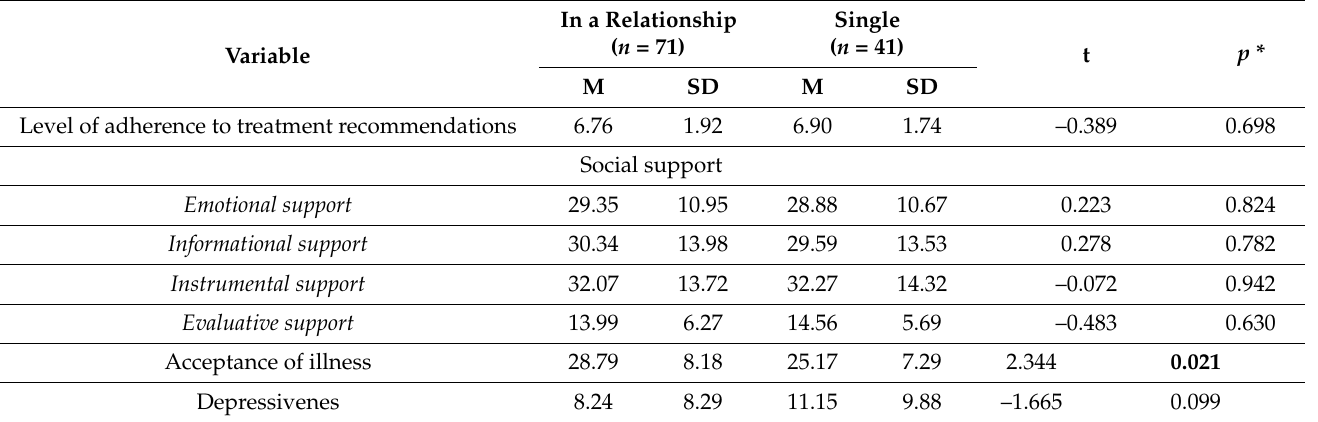
Table 6. The level of adherence to treatment recommendations, social support according to the ISSB, acceptance of disease according to the AIS, and depression according to the BDI among liver transplant patients by marital